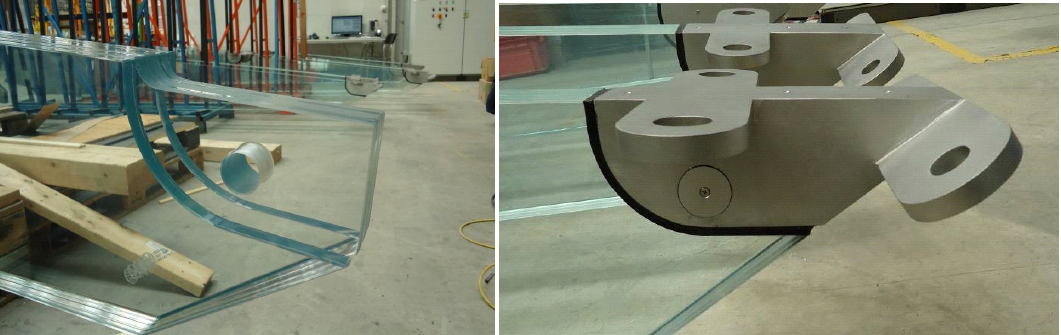
Fig. 3 front connection point between the glass fin – roof glass - fascia